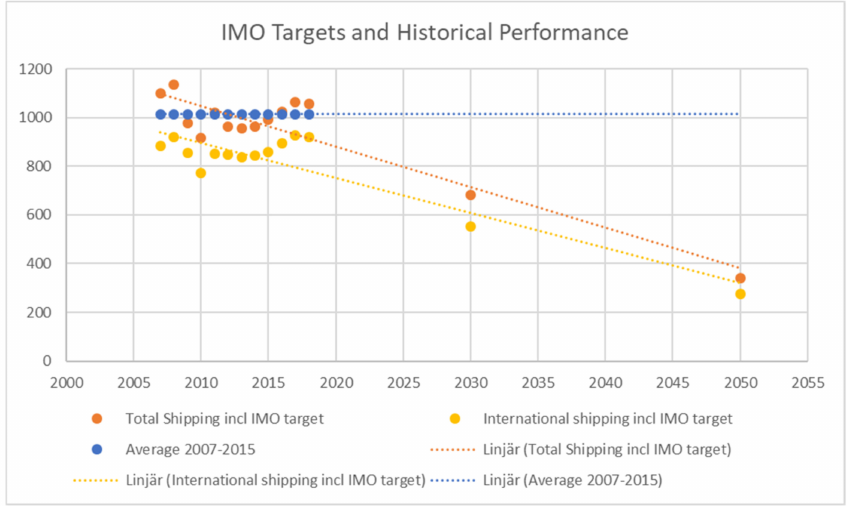
Figure 2. IMO targets and historical performance towards based on IMO and IPCC